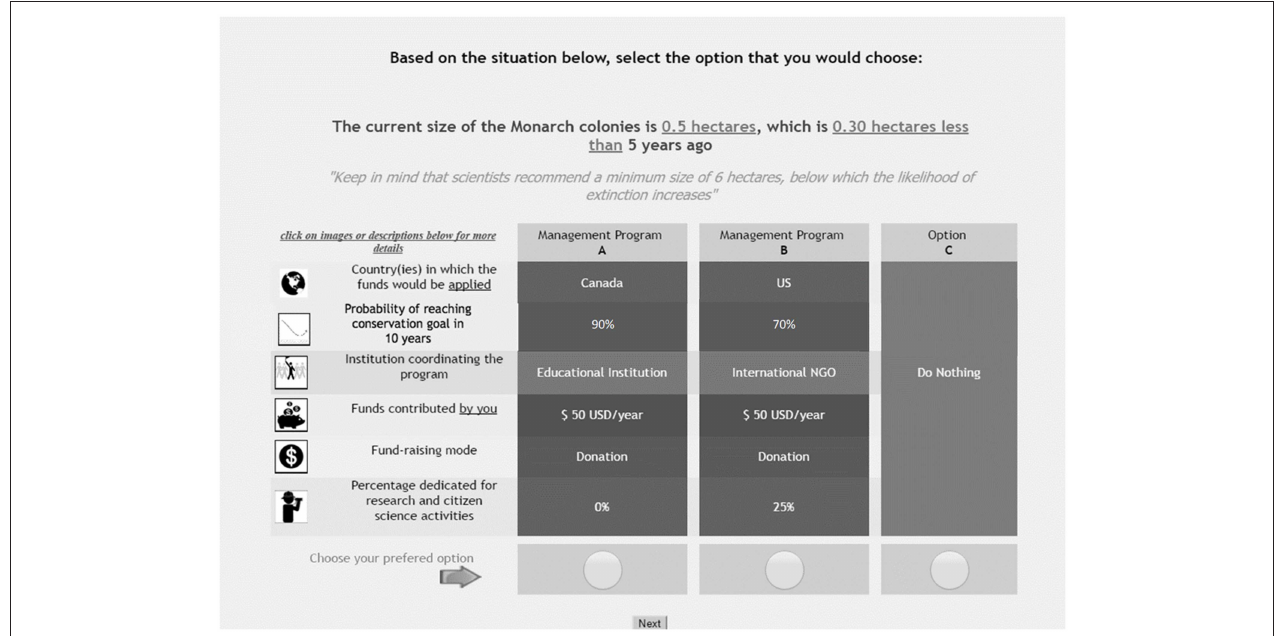
FIGURE 2 | Example of the choice experiment. Each management-program scenario showcases a different configuration of options, based on an orthogonal fractional factorial design. The top part of the screen, describing the hypothetical current situation of the monarch’s population, appears on the screen 7s before the management strategy to ensure that respondents read the information concerning the population trend. Respondents must select their preferred management strategy or to do nothing (alternative, “Option